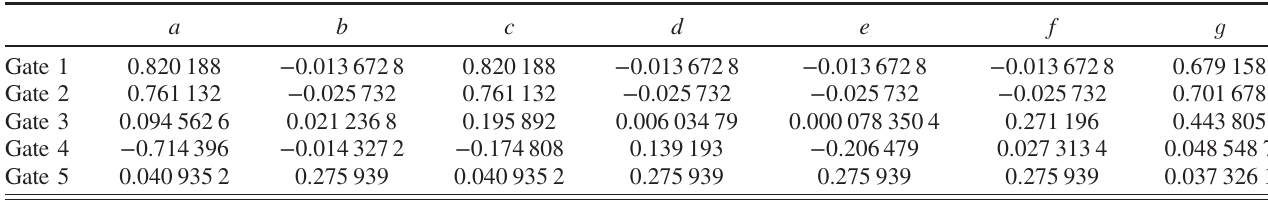
TABLE II. Parameters of the nonaveraged gates, which are used in the figures. The gates are parametrized as ð u ⊗ u Þ V ½f J with V ½f J defined in Eq. (54). The parameters are set to J 1 ¼ J 2 ¼ η þ π = 4 and J 3 ¼ 0 . 1 . i g(cid:2) Eigenvectors of λ 1 fulfill Eq. (88)